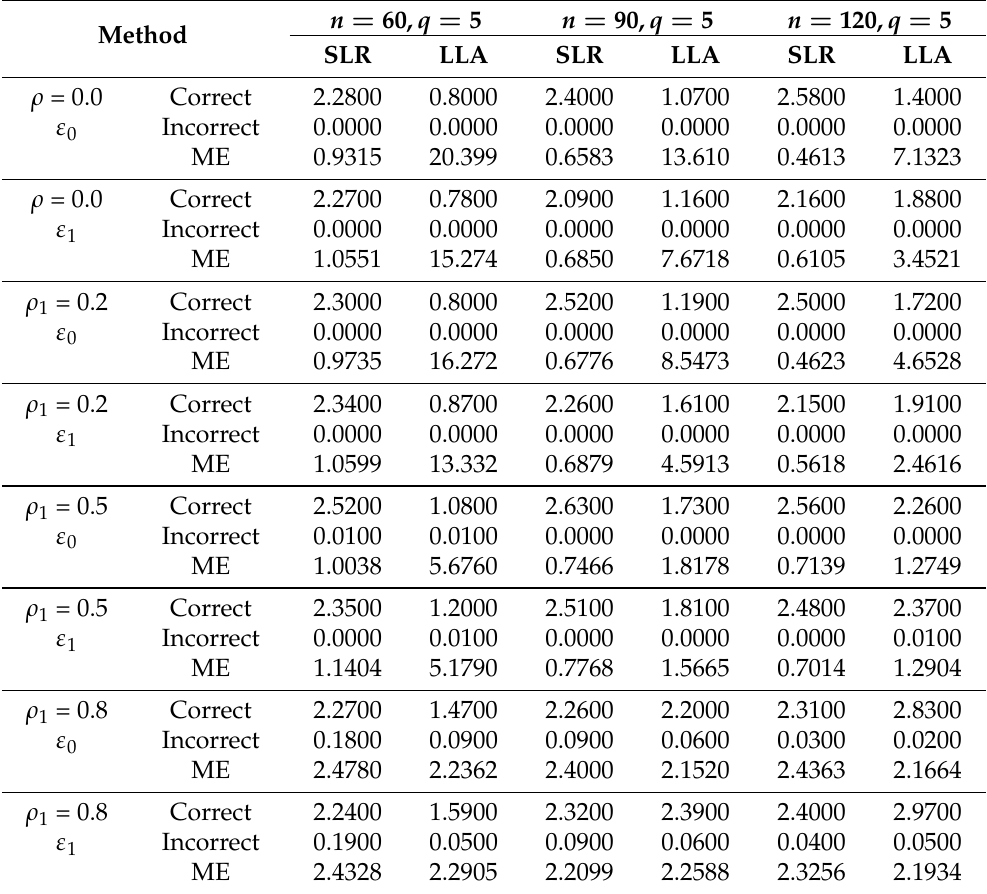
Table 2. Simulation results of variable selection via LASSO penalty function ( q =